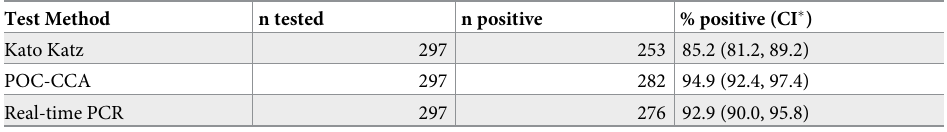
Table 1. Prevalence of S . mansoni according to each diagnostic method.